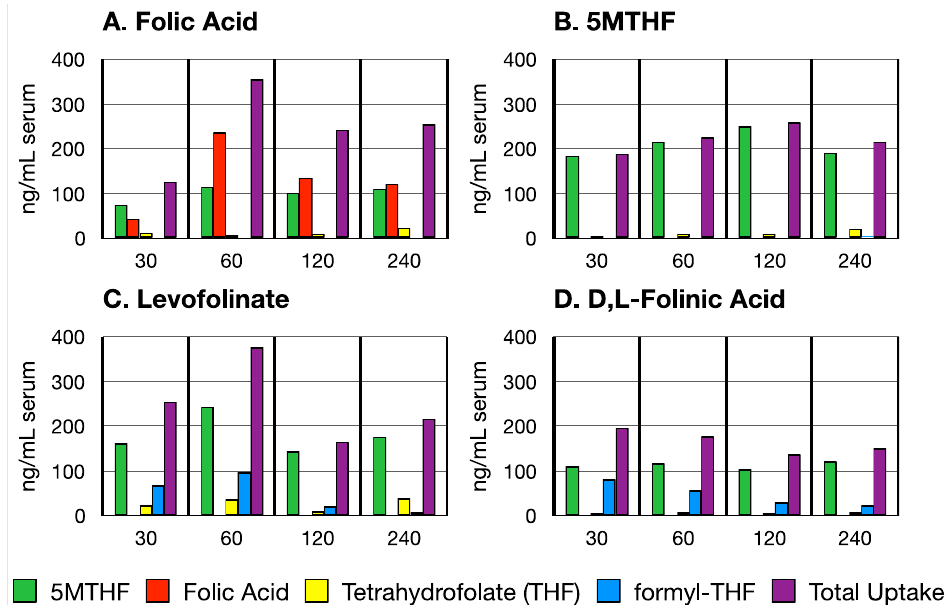
Figure 1. Serum concentration of folate forms following oral administration of PGA ( A ); L-5-methylfolate ( B ); Fusilev ( C ); Leucovorin ( D ); determined at 30 min, 60 min, 120 min, and 240 min post oral gavage. Values shown are ng/mL serum for all folate forms; Two rats were used for each folate form administered at each time point.